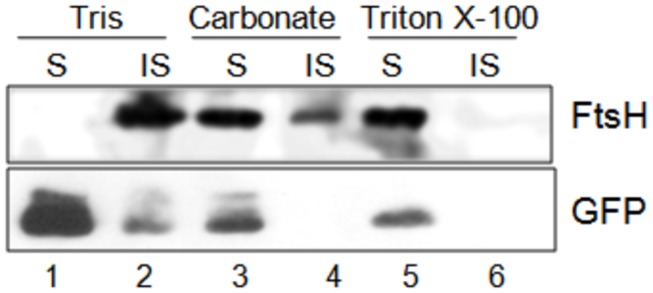

PfFtsH1 is a membrane-associated protein.
P. falciparum D10 ACPleader-GFP parasites were sequentially treated with Tris, sodium carbonate and Triton X-100 to investigate membrane association. Unlike apicoplast lumenal GFP, all PfFtsH1 was Tris-insoluble and only partially solubilised by carbonate buffer, indicating membrane association. Almost all PfFtsH1 was solubilised by Triton X-100. S, soluble fraction; IS, insoluble fraction.